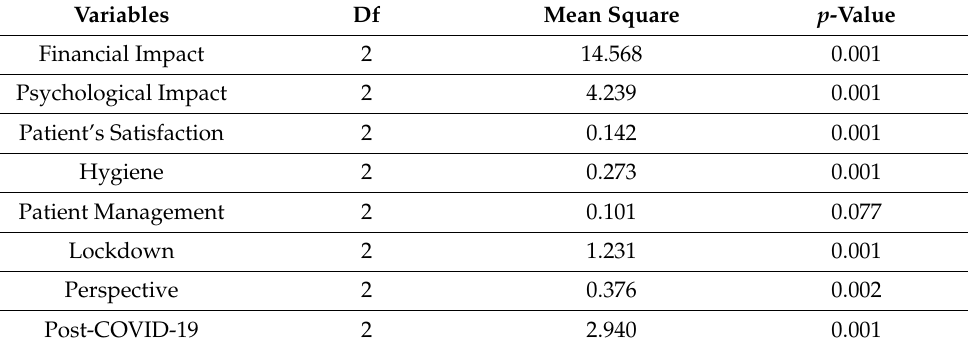
Table 7. Comparison of qualifications with dental